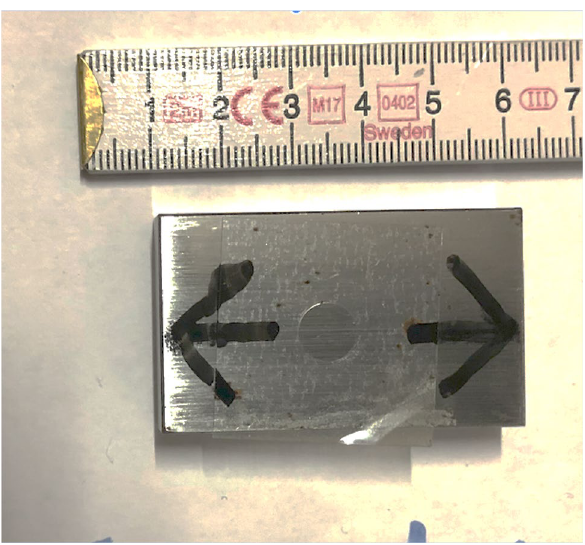
Fig. 2 Specimen GKN with the measurement direction like the arrows